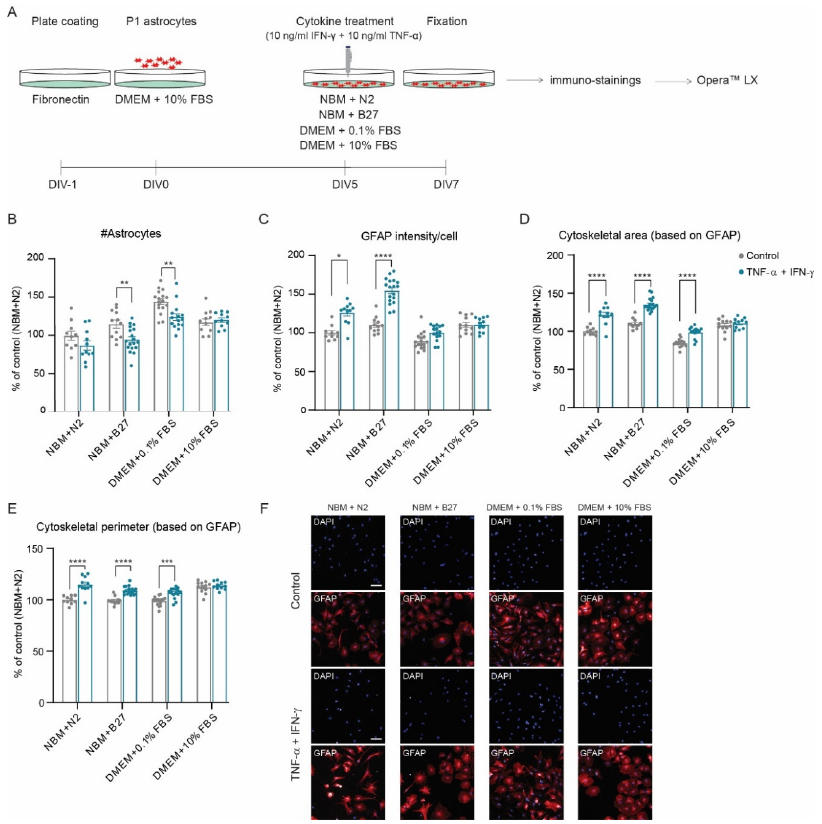
Figure 3. Cytokine-induced reactive astrogliosis in vitro: the effect of culture medium. ( A ) Experimental design. Analysis of ( B ) number of astrocytes, ( C ) GFAP intensity per cell, ( D ) cytoskeletal area (based on GFAP intensity), and ( E ) cytoskeletal perimeter (based on GFAP intensity). ( F ) Representative images of DAPI (blue) and GFAP (red) for each condition. Data were normalized to NBM + N2 unstimulated (N = 10–18 wells/condition; n = 14,298 and n = 10,963 astrocytes analyzed for NBM + N2 unstimulated and stimulated condition, respectively; n = 10,823 and n = 25,485 for NBM + B27 condition; n = 37,021 and n = 27,801 for DMEM + 0.1% FBS condition; and n = 21,259 and n = 19,921 for DMEM + 10% FBS condition). Data are presented as the mean ± SEM. Two-way ANOVA with a Bonferroni post hoc test: * p < 0.05, ** p < 0.01, *** p < 0.001, and **** p < 0.0001. Scale bar: 100 µ